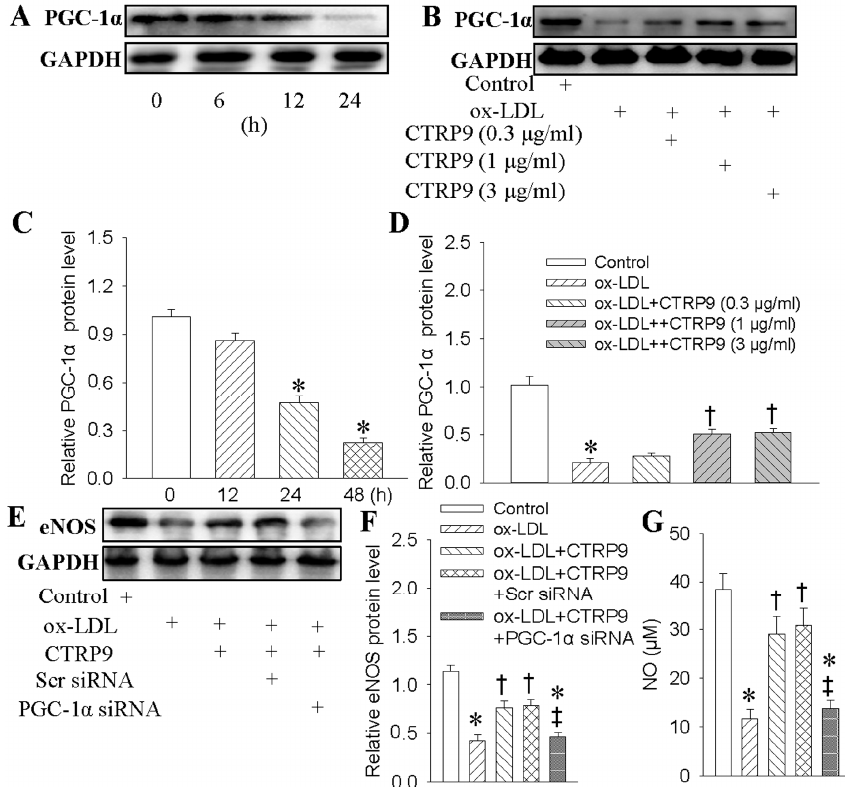
Figure 5. Proliferator-activated receptor γ co-activator 1 α (PGC1- α ) was involved the protective effects of CTRP9 against ox-LDL-evoked injury in HUVECs. ( A , C ) HUVECs were treated with ox-LDL (100 µ g/mL) for different time. The PGC1- α protein expression was determined with Western blot; ( B , D ) HUVECs were pretreated with CTRP9 (0.3, 1, 3 µ g/mL) for 6 h, and then were exposed to ox-LDL (100 µ g/mL) for 24 h. The PGC1- α protein expression was determined with Western blot. ( E , F ) HUVECs were transfected with Scrambled (Scr) siRNA or PGC-1 α siRNA for 24 h, and then incubated with CTRP9 (3 µ g/mL) for 6 h followed by ox-LDL (100 µ g/mL) challenge for 24 h. The eNOS protein expression was determined with Western blot; ( G ) NO levels were quantified by Griess assay. Values are mean ± SE. * p < 0.05 vs. 0 h, Control, † p < 0.05 vs. ox-LDL, ‡ p < 0.05 vs. ox-LDL+ CTRP9 or ox-LDL+ CTRP9 + Scr siRNA. n = 4 for each group from A to F , n = 6 for group G.